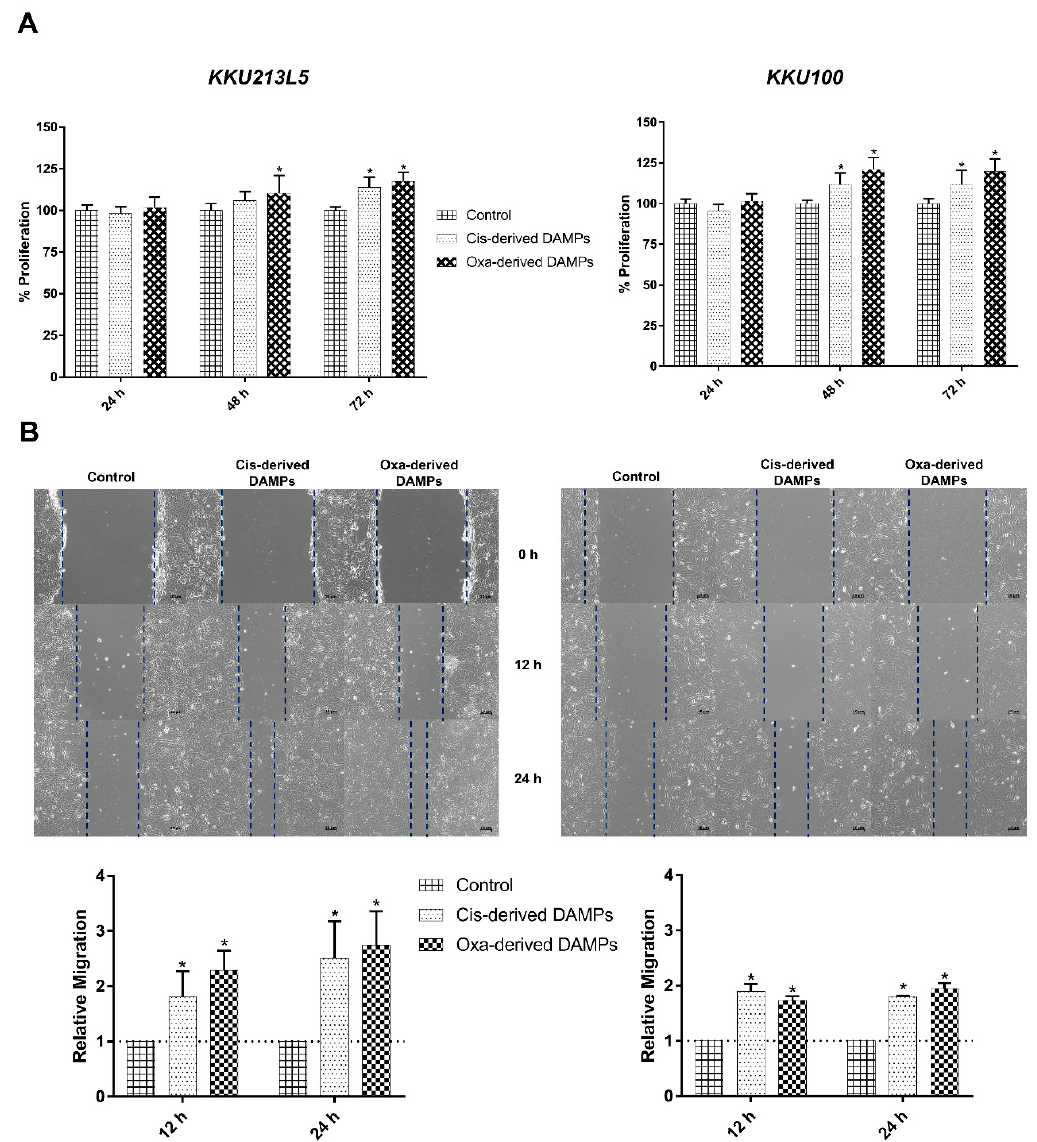
Figure 4. Chemo drugs-derived DAMPs promoted protumor activities. ( A ) KKU213L5 and KKU- 100 were incubated with cisplatin- and oxaliplatin-derived conditioned medium and incubated for indicated times, cell viability was measured and quantified as %proliferation compared with control medium. In addition, the conditioned media were used to challenge with cell scratch assay ( B ). Wound closure was monitored at 12 and 24 h after treatment and measured wound area by ImageJ software version 1.8.0_172 (NY, USA). Data represented as relative migration that compare with control group. * p < 0.05.